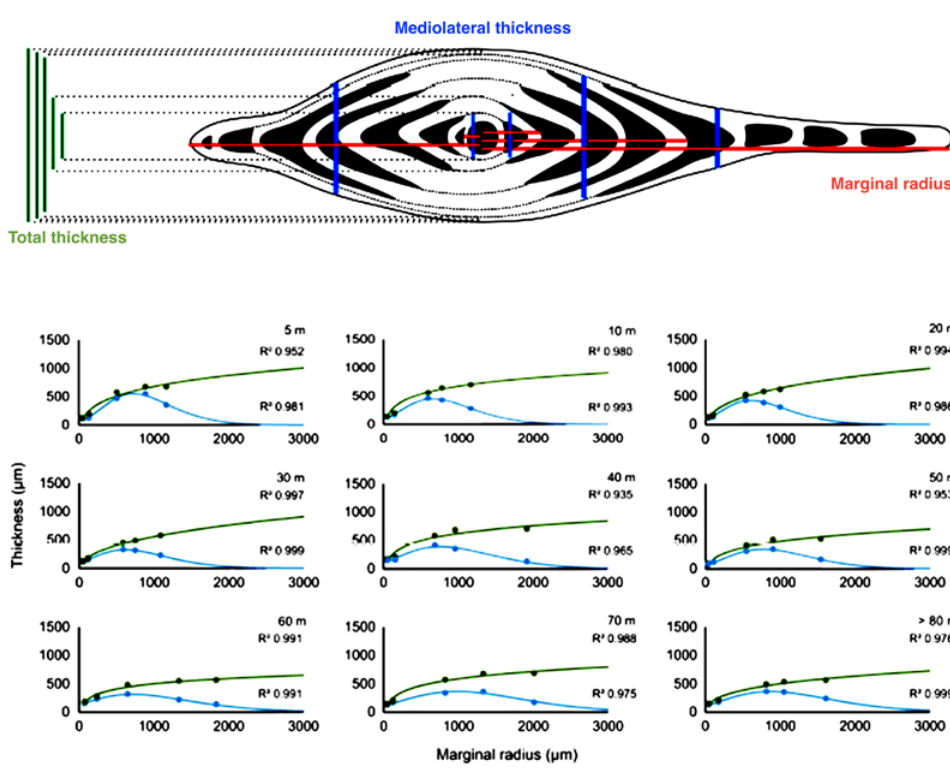
Figure 7. Example of using growth characteristics as an indicator of the bathymetry